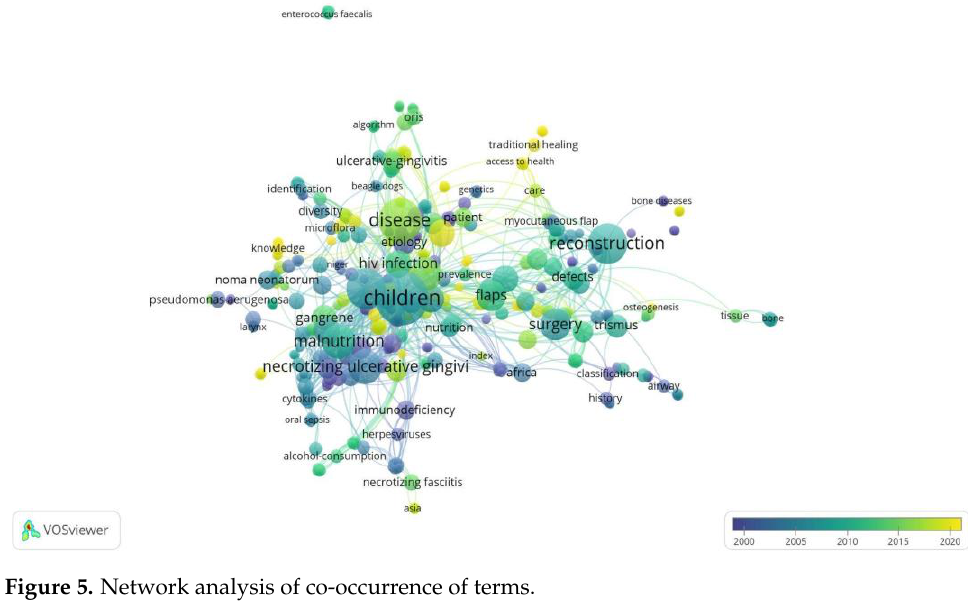
Trop. Med. Infect. Dis. 2022 , 7 , x FOR PEER REVIEW